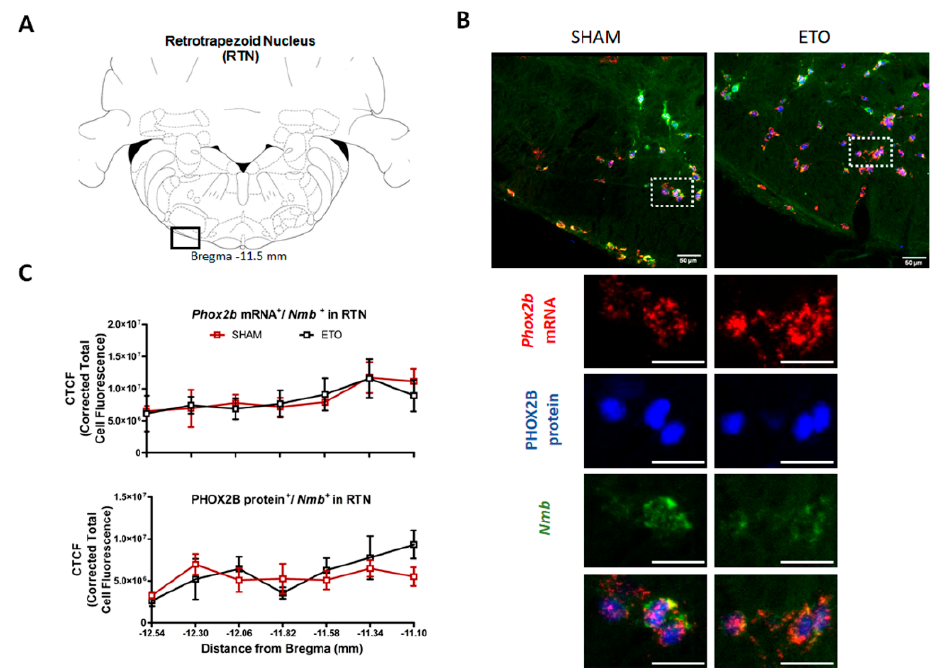
Figure 3. ETO does not affect expression of PHOX2B in RTN neurons . ( A ) Schematic and representative image of a transverse brainstem section at the level of the RTN ( − 11.5 mm distance from Bregma) showing. ( B ) RTN Phox2b + /Nmb + neurons in SHAM (left) and ETO (right) rats (magnified view insert). Scale bar = 50 μ m. ( C ) Mean-corrected total cell fluorescence (CTCF) value ± SEM calculated from five different rats per group (see methods for details) along the rostro-caudal extension of the RTN. Mean CTCF value ± SEM combined from five different animals per group.